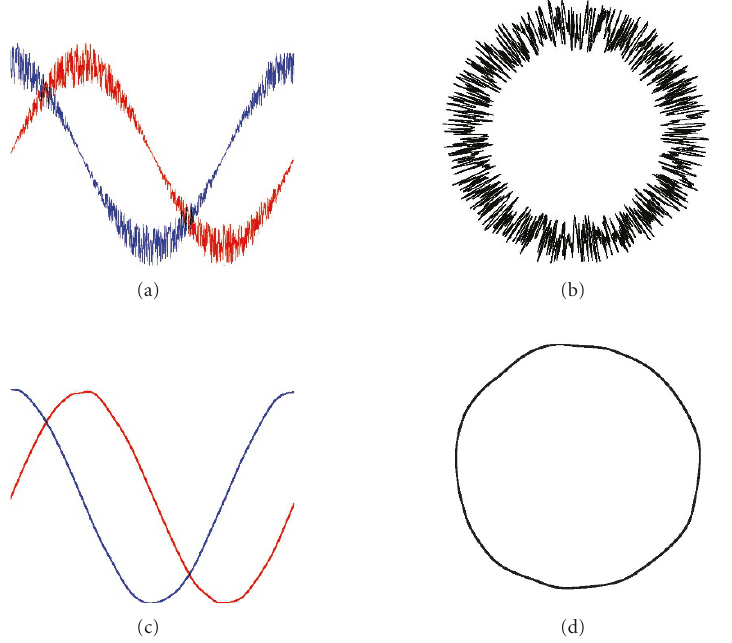
Figure 7: Smoothing B-spline filtering of a parametric circle with parameter s . Noisy circle in (b) is described by x ( s ) and y ( s ) (a). The circle in (b) has a constant radius disturbed by a uniformly distributed additive noise. x ( s ) and y ( s ) are smoothed separately by the smoothing B-spline filter (c). (d) shows the smoothed parametric circle.